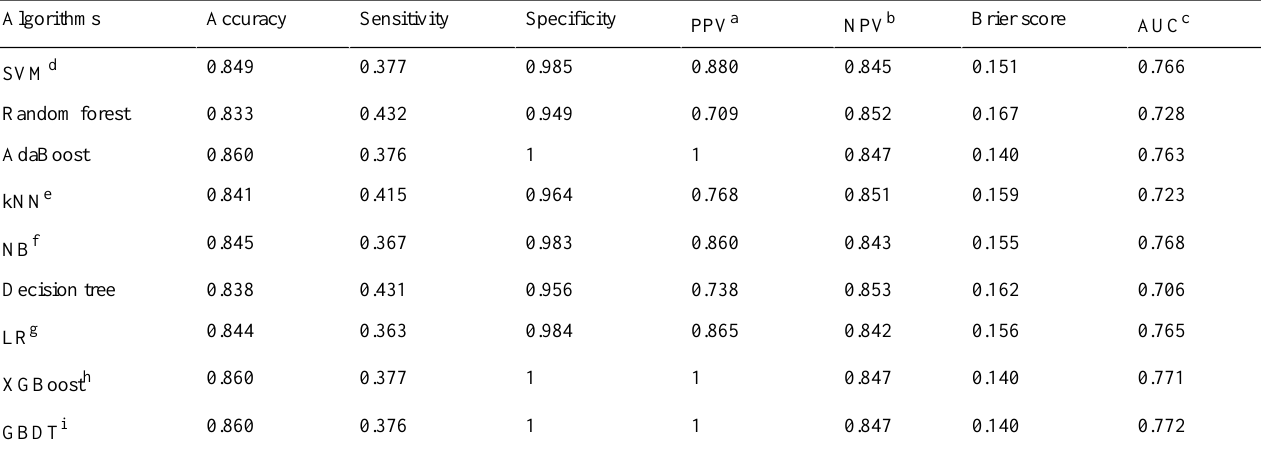
Table 2. The detection performance of 9 algorithms for the internal validation